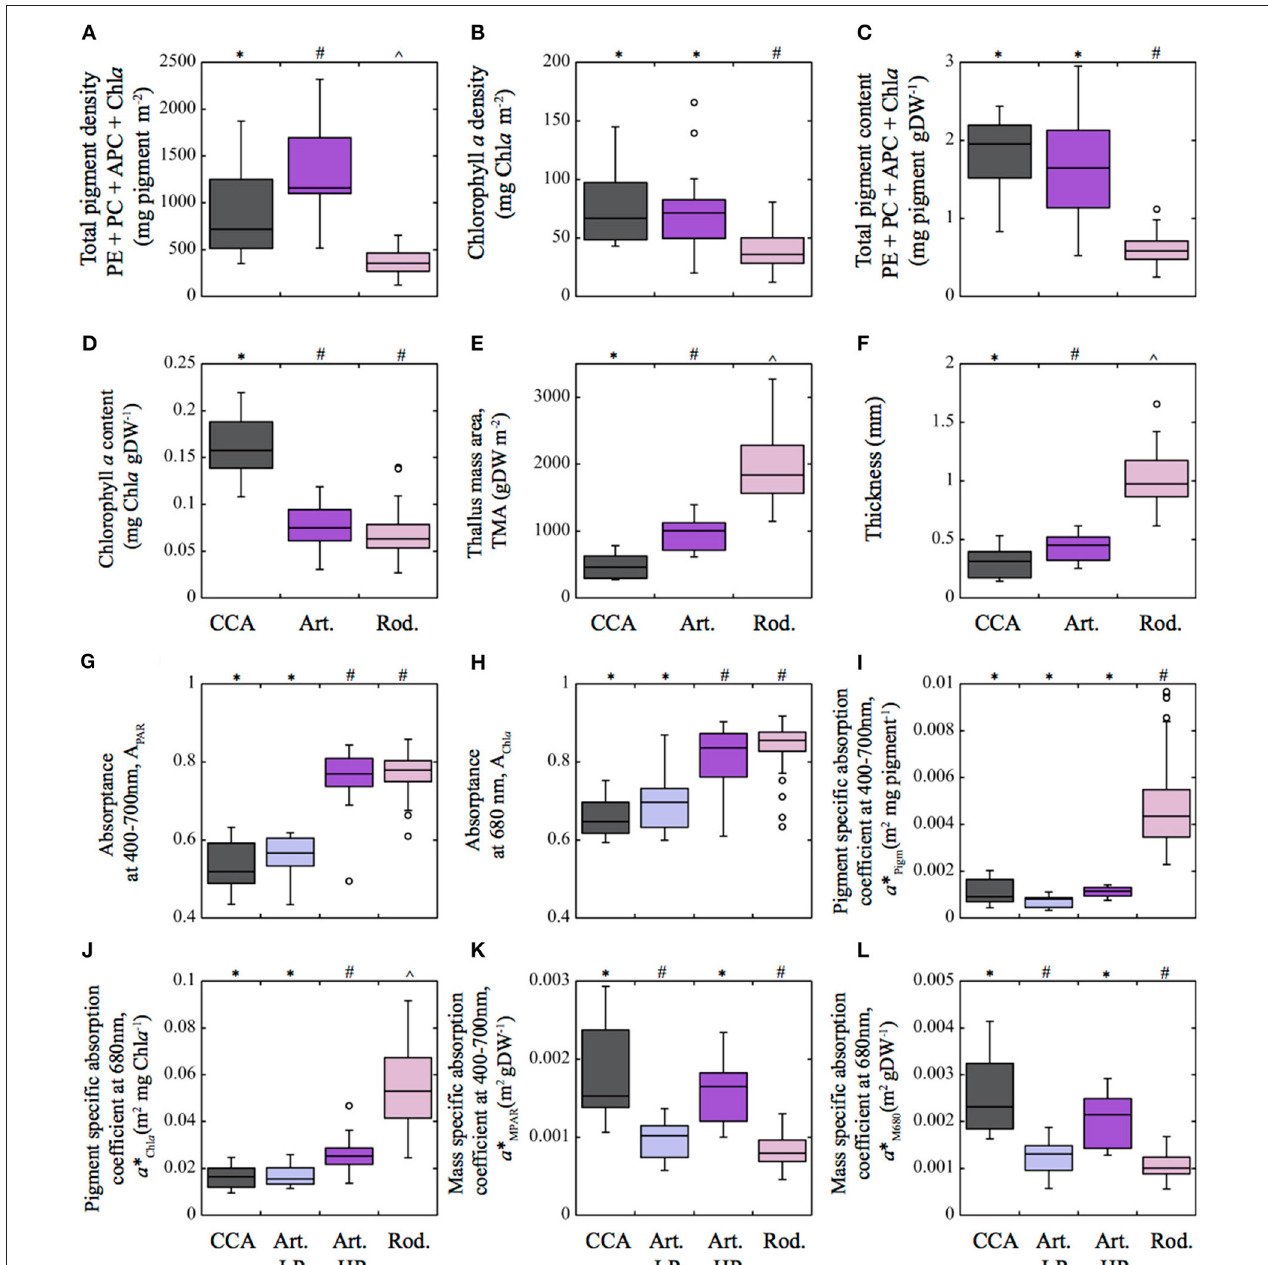
FIGURE 2 | Box plot showing the distribution of the different structural and optical thallus descriptors of the three coralline algae characterized in this study. (A) Total pigment density (mg pigm m − 2 ) and (B) Chlorophyll a density (mg Chl a m − 2 ); (C) Total pigment content (mg pigm gDW − 1 ) and (D) Chlorophyll a content (mg Chl a gDW − 1 ); (E) Thallus mass area (TMA, gDW m − 2 ); (F) thallus thickness (mm); (G) Absorptance for the PAR average (A PAR ) and (H) for the Chl a red peak at 680 nm (A Chl a ); (I) pigment specific absorption coefficient for the PAR average ( a * Pigm ; m 2 mg pigm − 1 ) and (J) for the Chl a red peak at 680 nm ( a * Chl a ; m 2 mg Chl a − 1 ); (K) mass specific absorption coefficient ( a * MPAR ; m 2 gDW − 1 ) for the PAR average and (L) for the Chl a red peak at 680 nm ( a * M680 ; m 2 gDW − 1 ). Total pigment refers to the sum of phycoerythrin (PE), phycocyanin (PC), allophycocyanin (APC) as well as chlorophyll a (Chl a ). Boxes encompass the 25 and 75% quartiles of all the data for each growth-form, the central horizontal line represents the median, bars extend to the 95% confidence limits, and open circles represent observations extending beyond the 95% confidence limits. Different symbols above the occurence of boxes indicate significant differences between species (one way ANOVA P < 0.05, Tukey post-hoc P < 0.05). Color of the boxes: pink for the rhodolith Neogoniolithon sp; purple for the articulated alga; and gray for the crustose coralline Lithothamnion sp. (CCA). In (G–L) the purple and blue color corresponds, respectively, to the highly pigmented (HP) and lesser pigmented (LP) sides of the thalli of the articulated alga. Sample size for the descriptors: rhodoliths n = 54–63, articulated n = 15–19, CCA n = 12.